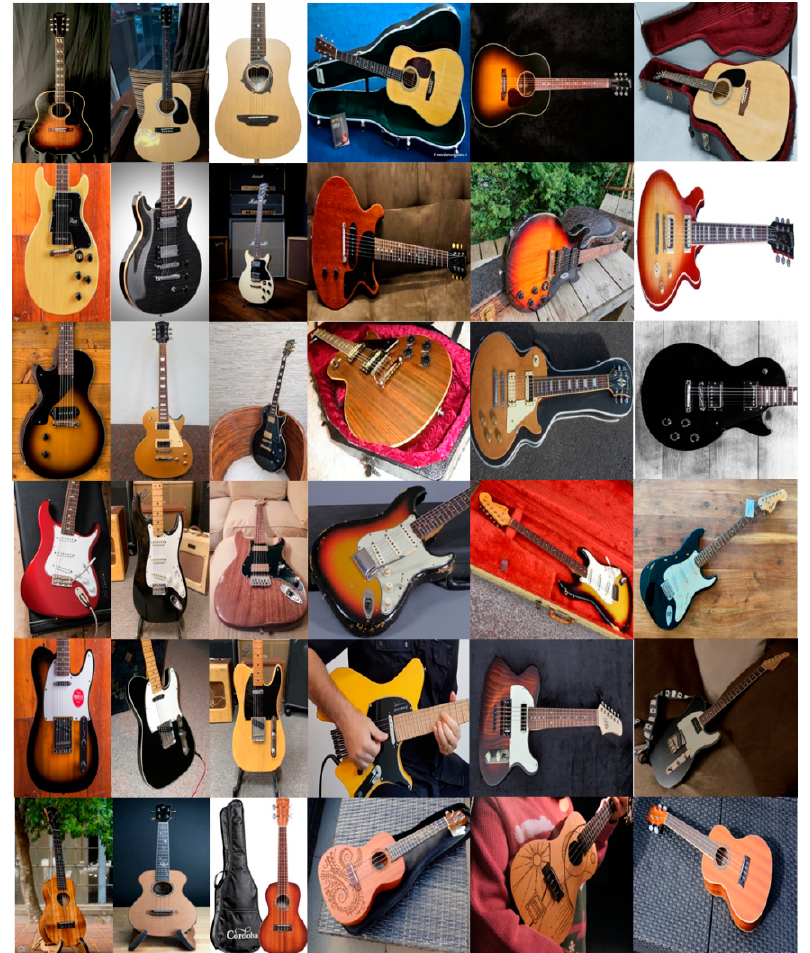
Figure 4. Sample of the guitar database.